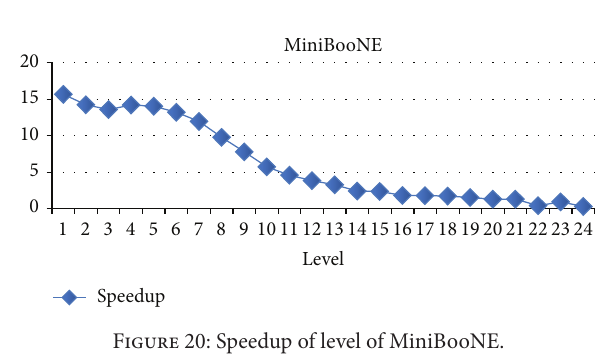
Figure 22: Active data size versus node size on Magic04.